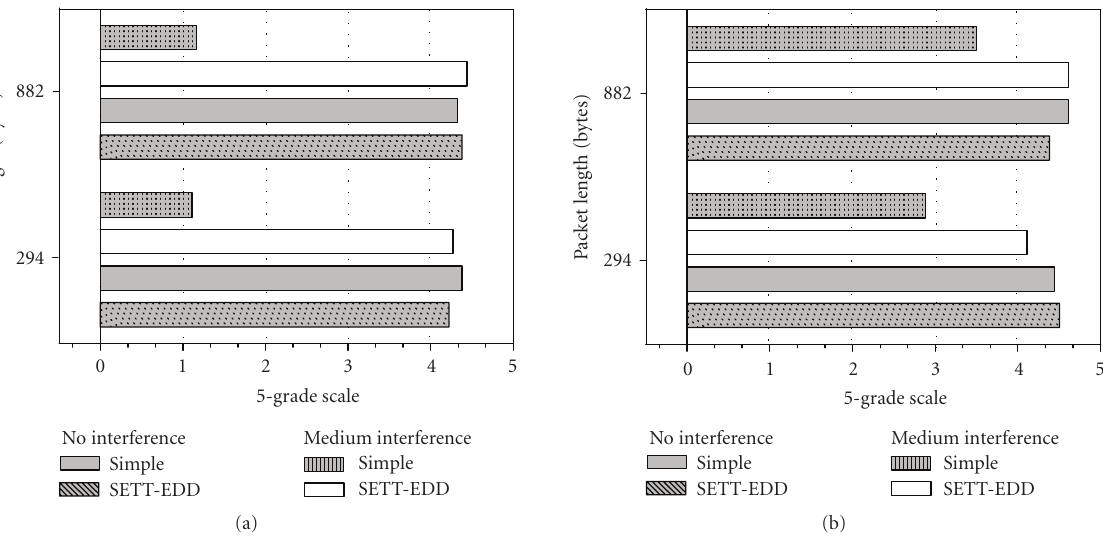
Figure 11: Subjective test results for PCM audio WLAN streaming delivery: (a) CoDeS disabled; (b) CoDeS enabled.